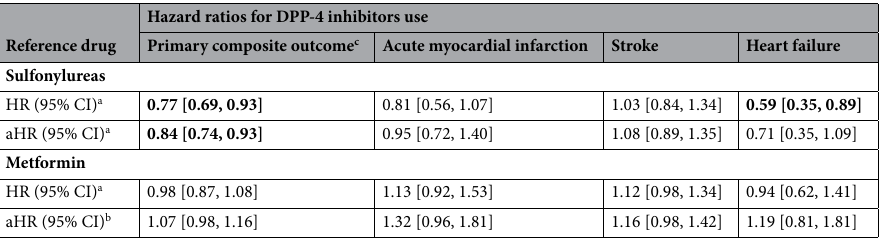
Table 3. Hazard ratios for the association between DPP-4 inhibitor use and primary composite outcome, acute myocardial infraction, stroke, and heart failure compared to sulfonylureas and metformin. a Propensity score weighting only. b Propensity score weighting and demographics, comorbidities, and concomitant medications as regressors and stratifiers. c Primary composite outcome includes myocardial infarction, cardiac arrest, coronary artery bypass, coronary angioplasty, heart failure, stroke, inpatient death. Bold values indicate statistically significant results.